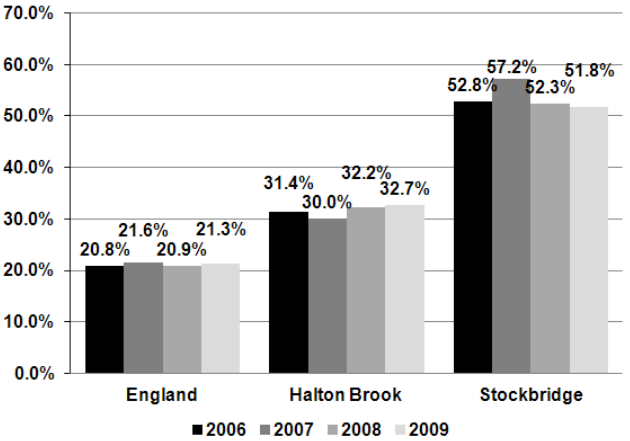
Figure 5. Children in poverty in HB and